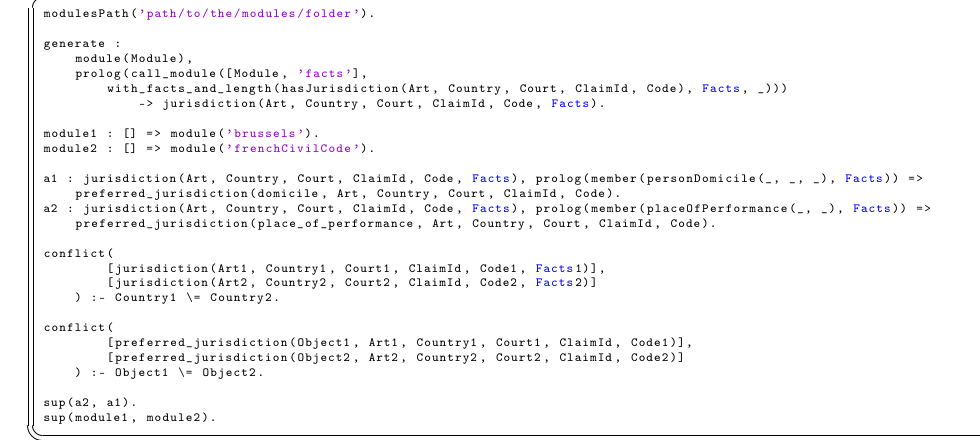
Figure 14. Conflict Prolog transposition.